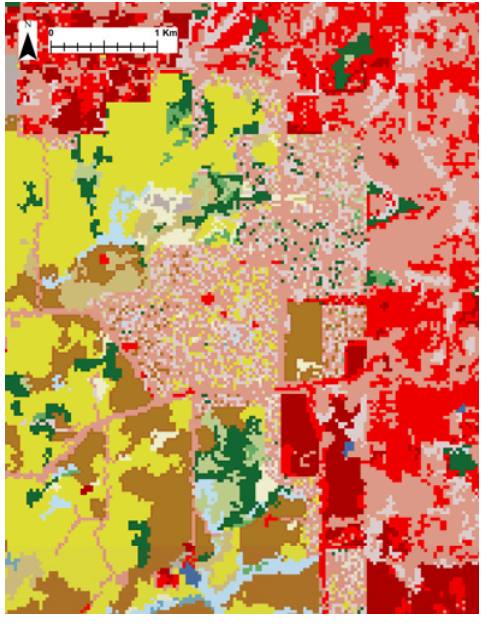
Figure 7. Example of grid cell raster mosaic phenomena depicting potential future land cover change. Exact arrangement of grid cells is determined randomly where there are more candidate pixels for transformation than are